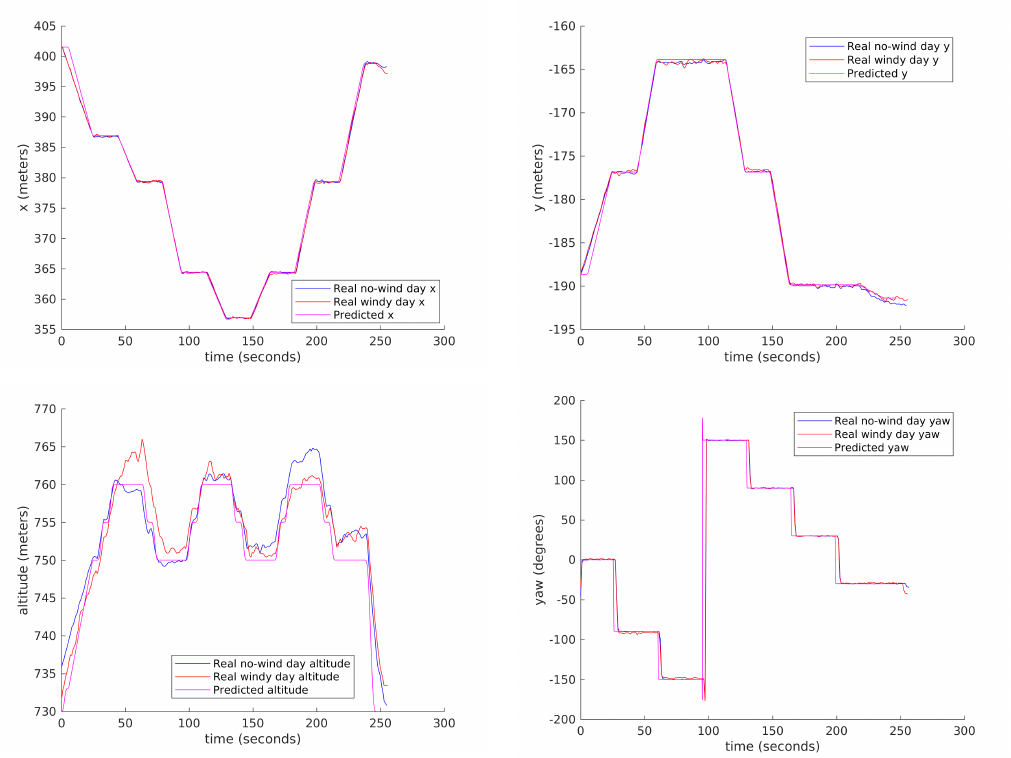
Figure 16. Mission execution and simulated results (x ( top-left ), y ( top-right ), altitude ( bottom-left ) and yaw ( bottom-right )).